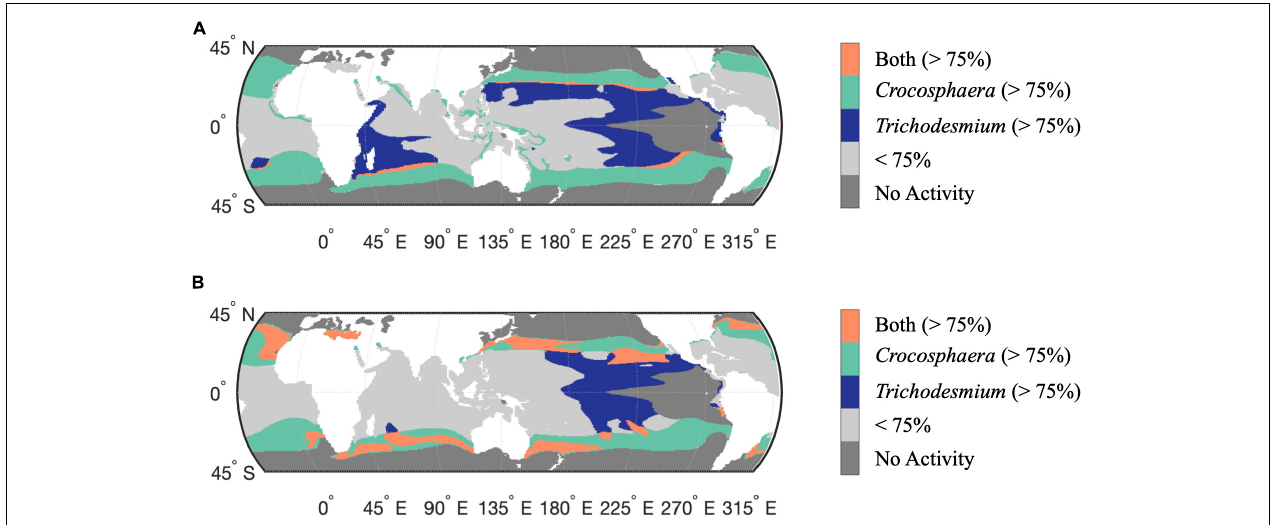
FIGURE 4 | Comparative change in the modeled responses of Crocosphaera and Trichodesmium N-IUE (A) and N 2 -fixation (B) for the years 2010 and 2100 under the IPCC RCP 8.5 warming. Colored areas mark where the percent change in physiology is predicted to increase the most (above the 75% quantile) for either diazotroph, green ( Crocosphaera ) and purple ( Trichodesmium ) with the overlap between the two diazotrophs colored in orange. Light gray masked areas mark areas where activity is below the 75% quantile for either diazotroph. Gray masks regions of assumed no activity where nitrate concentrations are > 5 µ M or where temperatures are outside the thermal range, and where modeled growth rates are consequently assumed to be negligible ( < 0.01 day - 1 ).